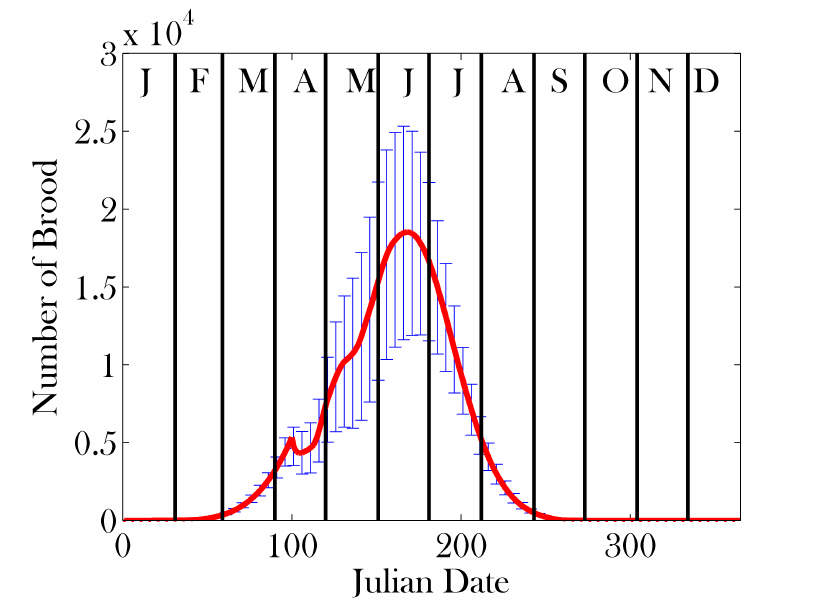
Figure 5. Results of sensitivity analysis on brood size: mean (red line) ± one standard deviation (error bars). Parameter sets were sampled using Latin hypercube sampling [61] with 10 divisions from the mean values provided in Table 1, ranging ± 20%. The parameters on which sensitivity analysis was performed appear in bold in Table